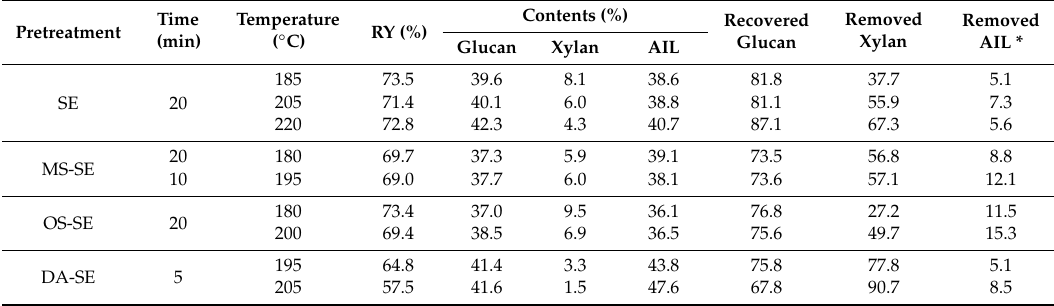
Table 2. Chemical composition of pretreated solids (WIS) under various pretreatment conditions. Data are expressed as dry